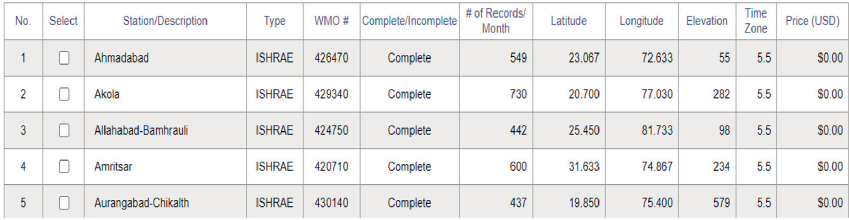
Figure 1: Web user interface of ISHRAE.